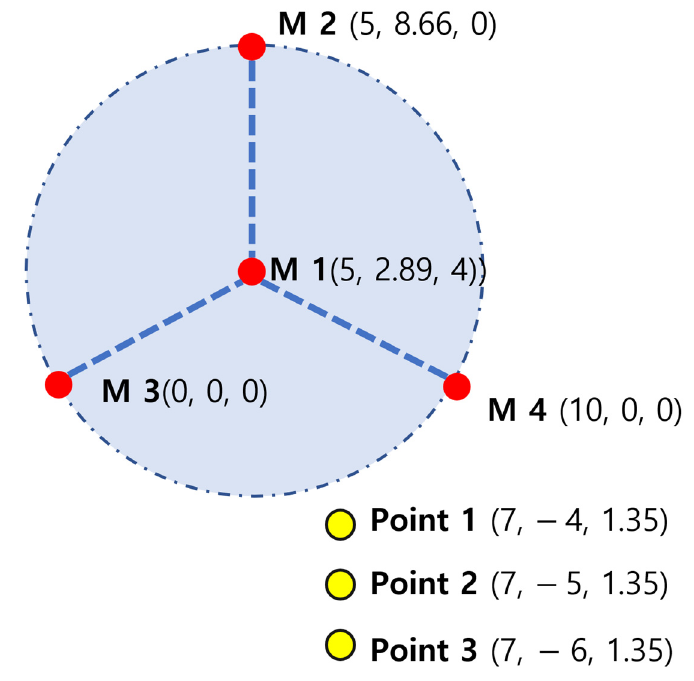
Figure 11. Geometry of the interior construction site validation test 2.